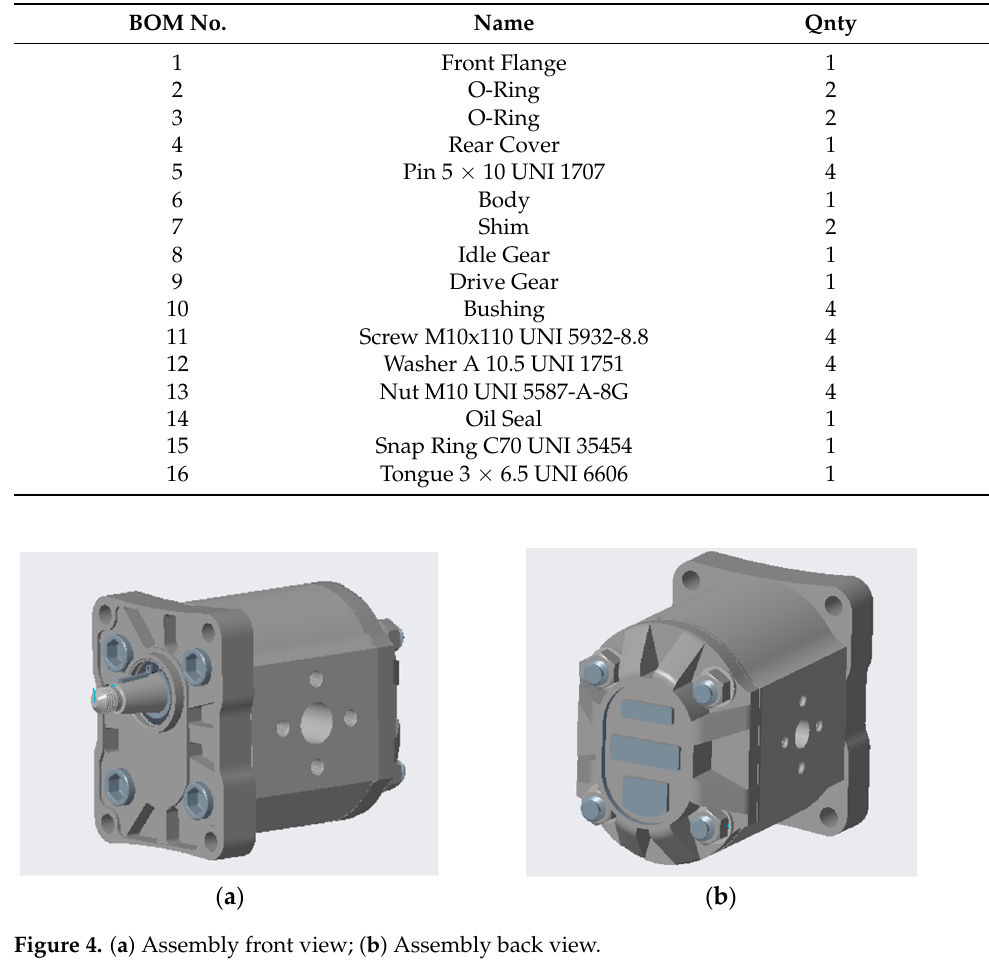
Table 1. Bill of materials.